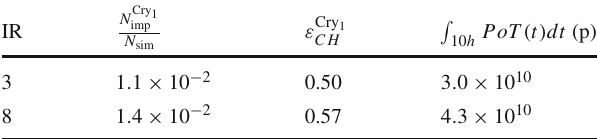
Table 6 Fraction of simulated protons that hit the Cry 1 at 5 . 5 σ in both layouts and relative channeling efficiency, together with integrated PoT in a 10 h fill with 200 h beam lifetime. A total injected intensity of 2556 bunches with 1 . 1 × 10 11 protons per bunch is considered